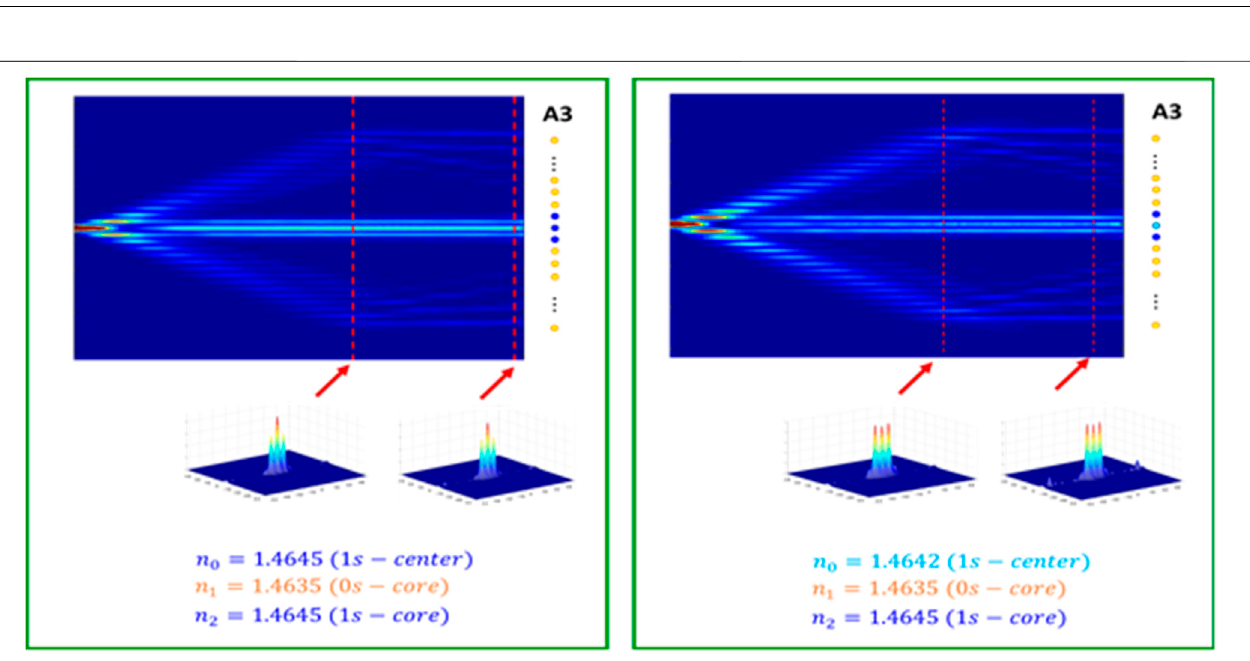
FIGURE 7 | Light propagation in standard BPL A3 in 5 mm (left panel) , and modi fi ed BPL A ’ 3 (right panel) . In the standard BPL, all cores A s have same index contrast Δ n A , and all cores B s have same index contrast Δ n B . In this example the standard BPL A3 (left) Δ n A (cid:1) 0.0045 and Δ n B (cid:1) 0.0035. In the modi fi ed BPL A ’ 3, all cores A s have same index contrast Δ n A (cid:1) 0.0045 except for the center (input) core, which has lightly lower Δ n A (cid:1) 0.0042, indicated by light blue color. All core B s have sameindexcontrast Δ n B (cid:1) 0.0035asinthestandardone.Ineachpanel,lower fi guresshowdistributionsattwodifferentdistancesindicatedbytworedlines.Note that, the distribution in modi fi ed BPL is more unformed than that in standard BPL.